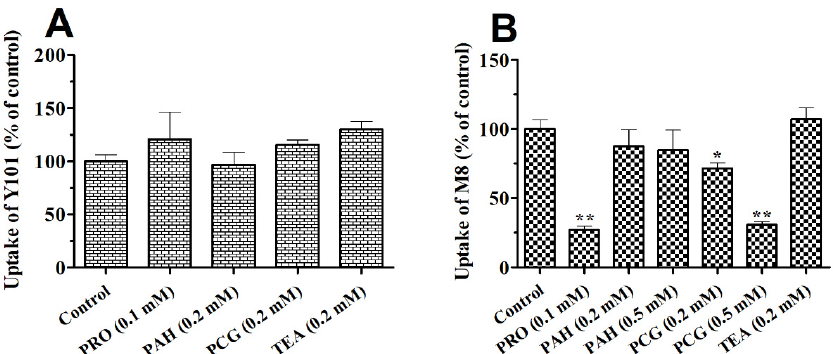
Figure 7. Effects of OATs inhibitors and substrates on the uptake of Y101 (2.0 µ M, ( A )) and M8 (5.0 µ M, ( B )) in kidney slices (*, p < 0.05; **, p < 0.01 vs. control). Data are expressed as mean ± SD, n = 3.